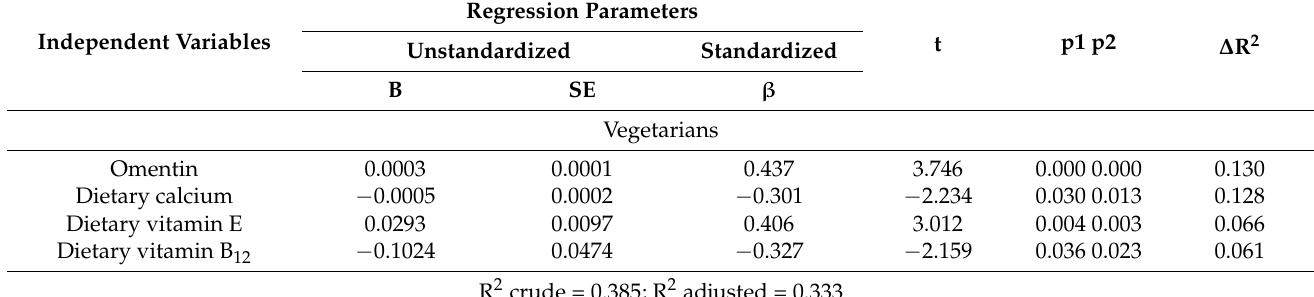
Independent Variables